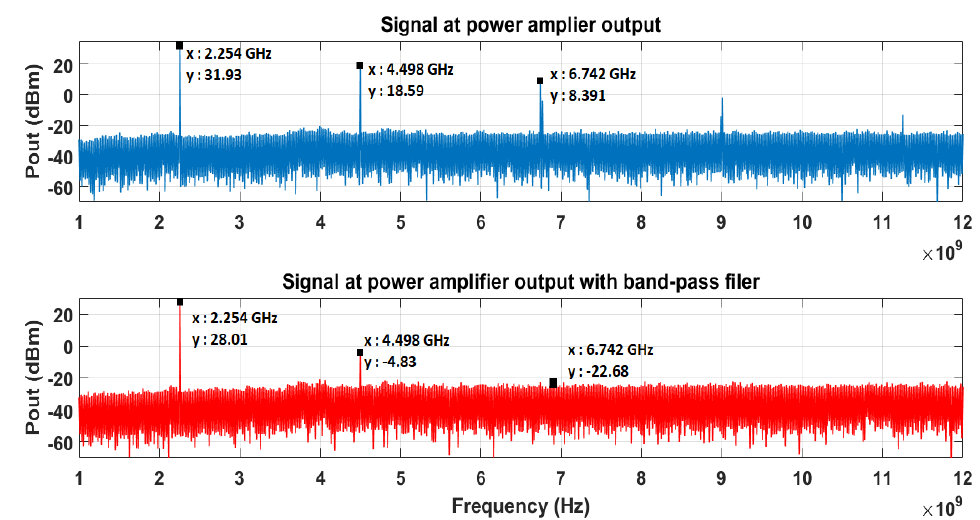
Figure 15. Comparison of signal at power amplifier output with and without band-pass filter.